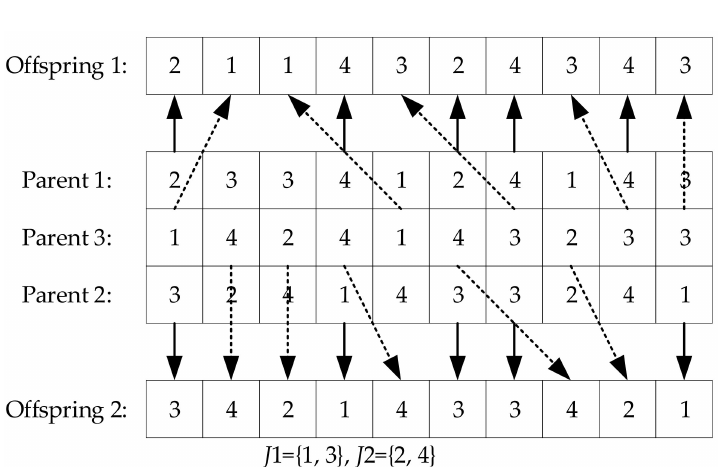
Figure 8. An example for